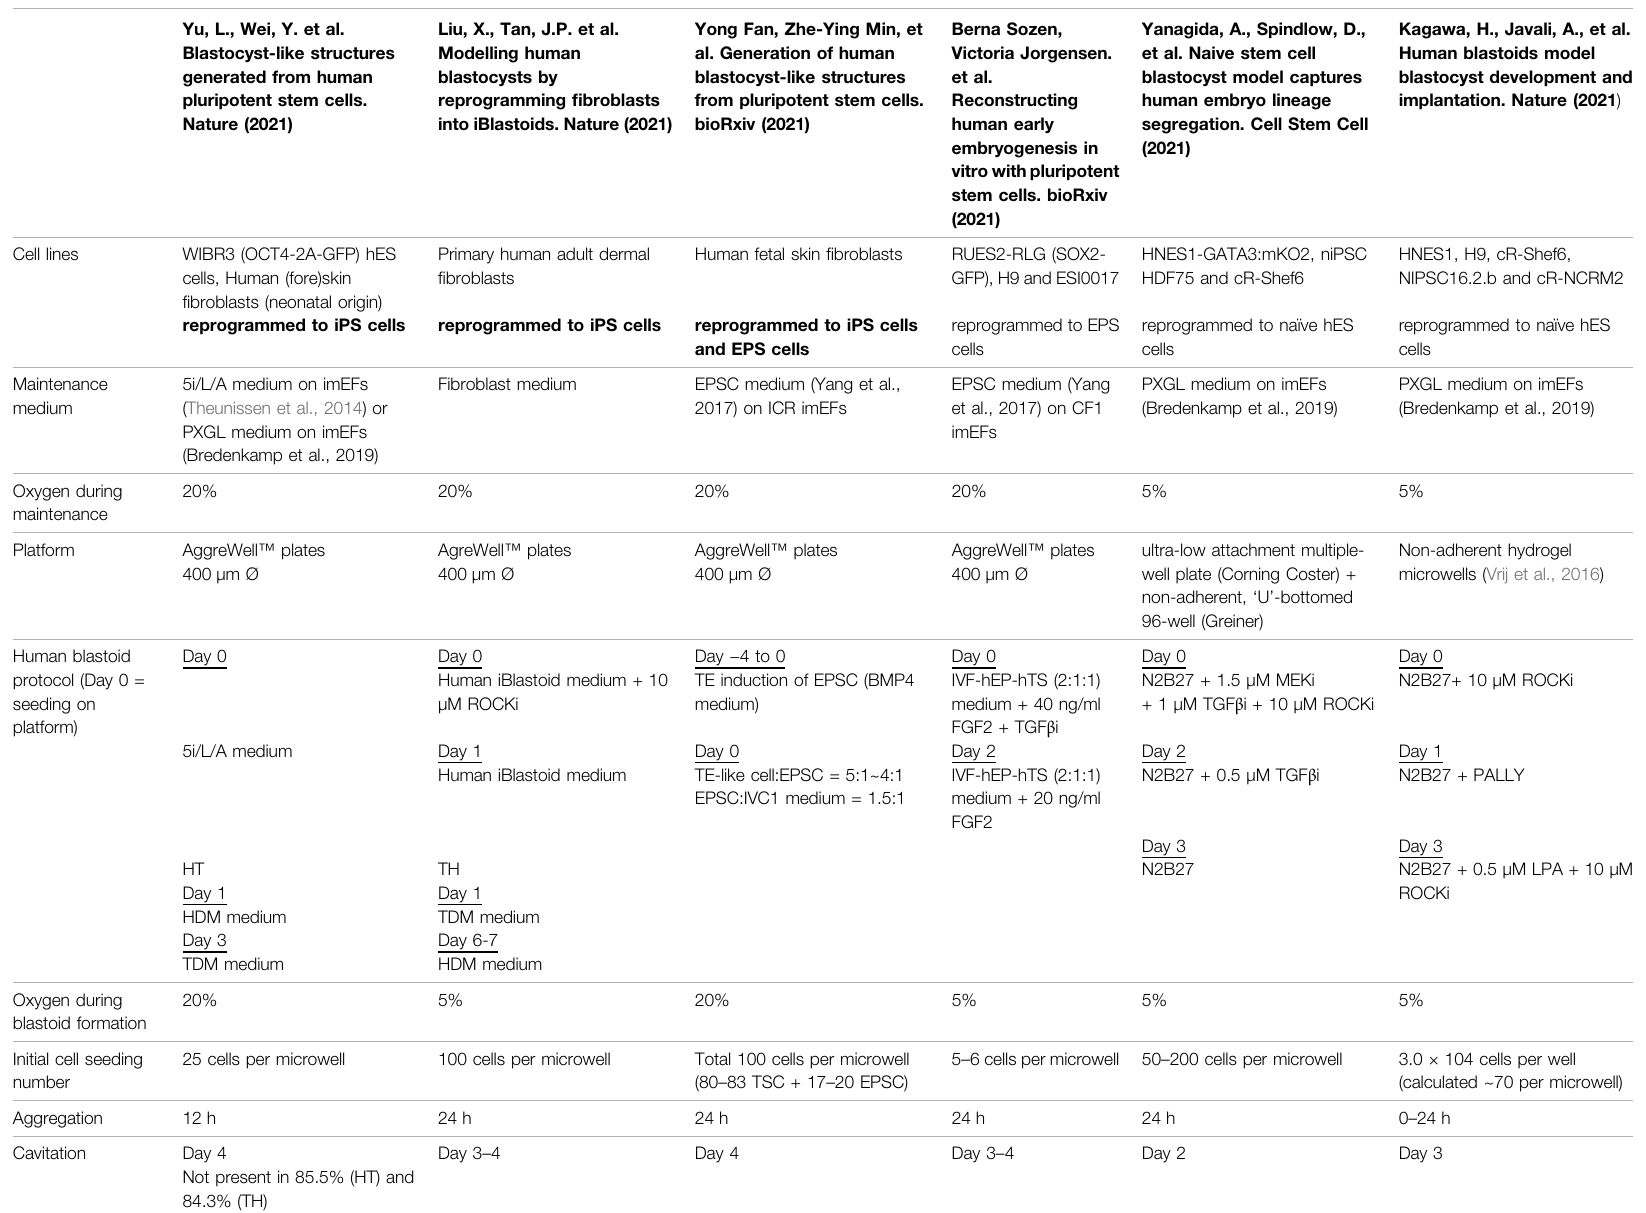
TABLE 2 | Overview human blastoid protocols, summarizing culture conditions, experimental time lines, blastocyst marker expression. Yu, L., Wei, Y. et al. Blastocyst-like structures generated from human pluripotent stem